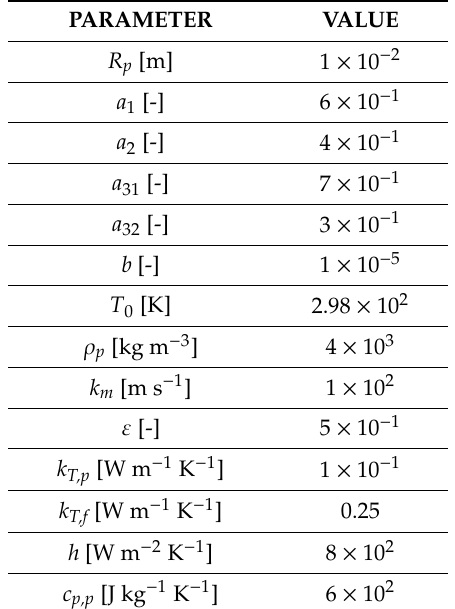
Table 1. Main parameters for the fluid and solid phases.